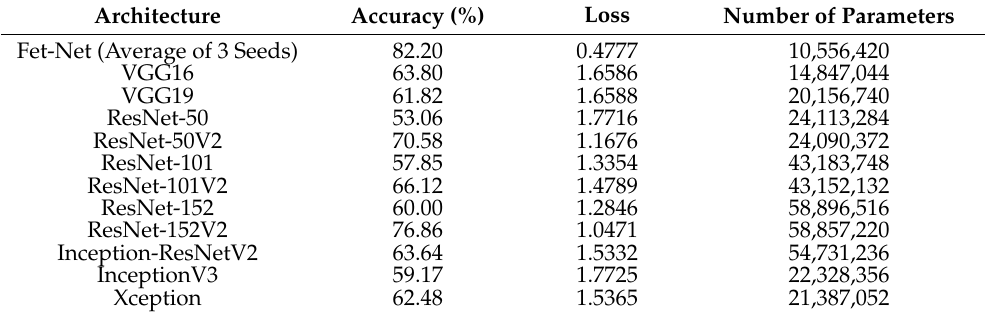
Table 3. Summary of performance metrics of Fet-Net and prominent CNN architectures during the validation